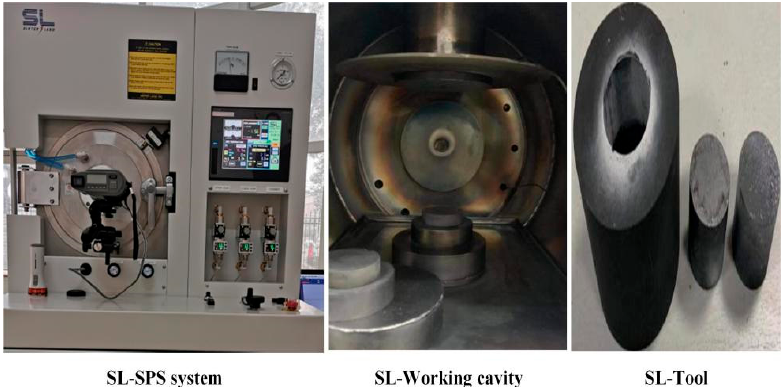
Figure 3. SL-spark plasma sintering (SPS) equipment (Sinter Land Iinc, Niigata Prefecture, Japan).